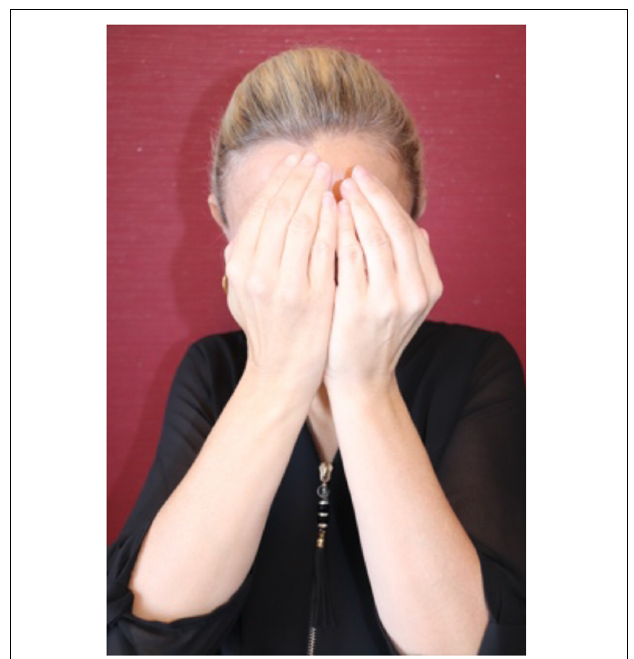
FIGURE 2 | G: TAKE-BY-THE-HAND.